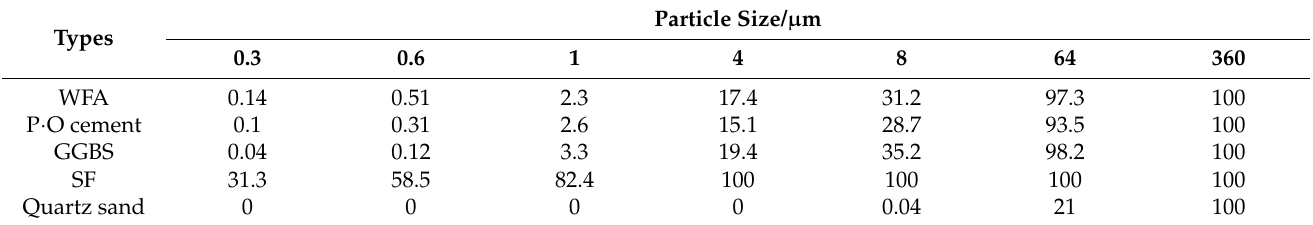
Table 1. The particle size distribution of the cementitious materials (%).